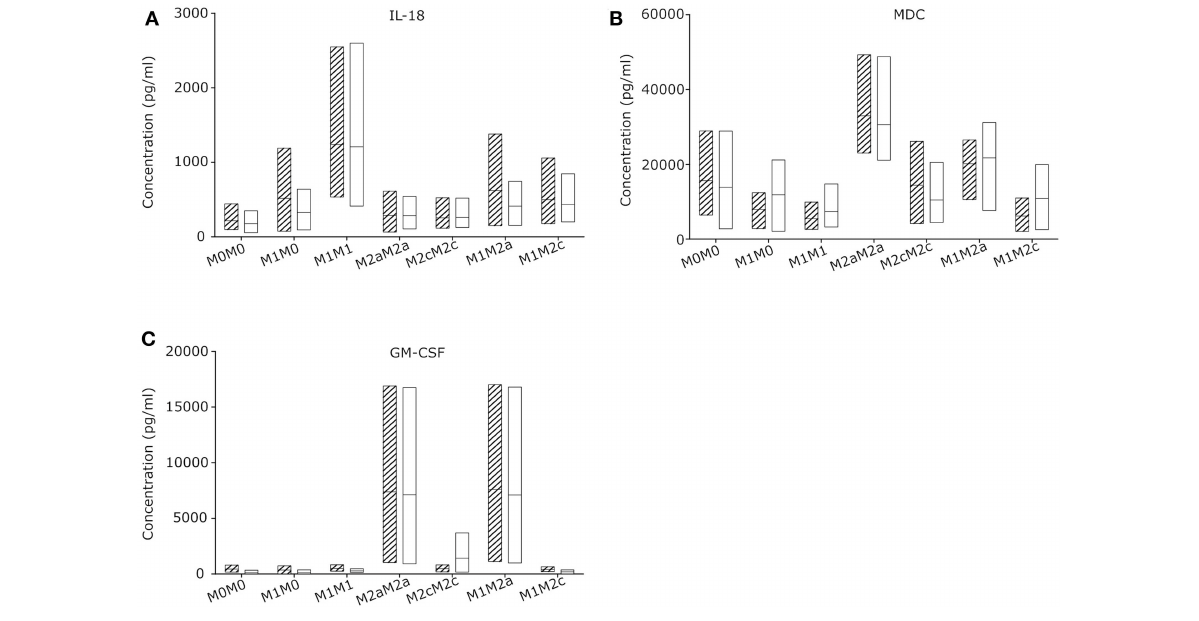
Frontiers in Immunology |